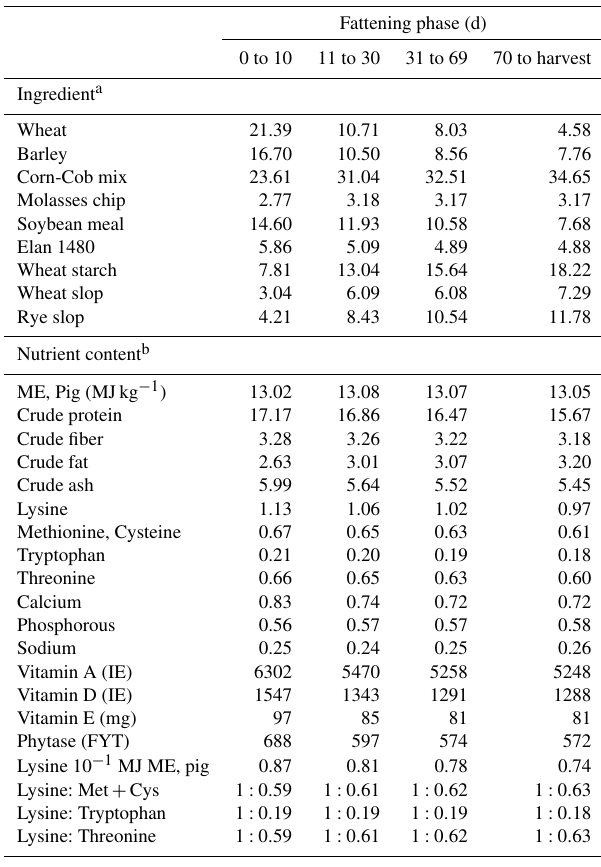
Table 1. Composition and nutrient content of the pig diets (%, as- fed basis, unless otherwise